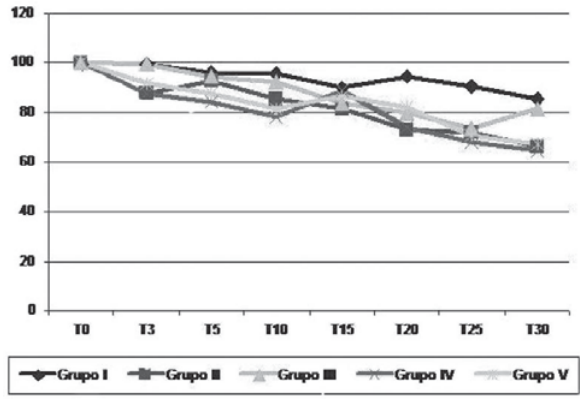
Fig.4 - Variação percentual do fluxo coronariano em mililitros